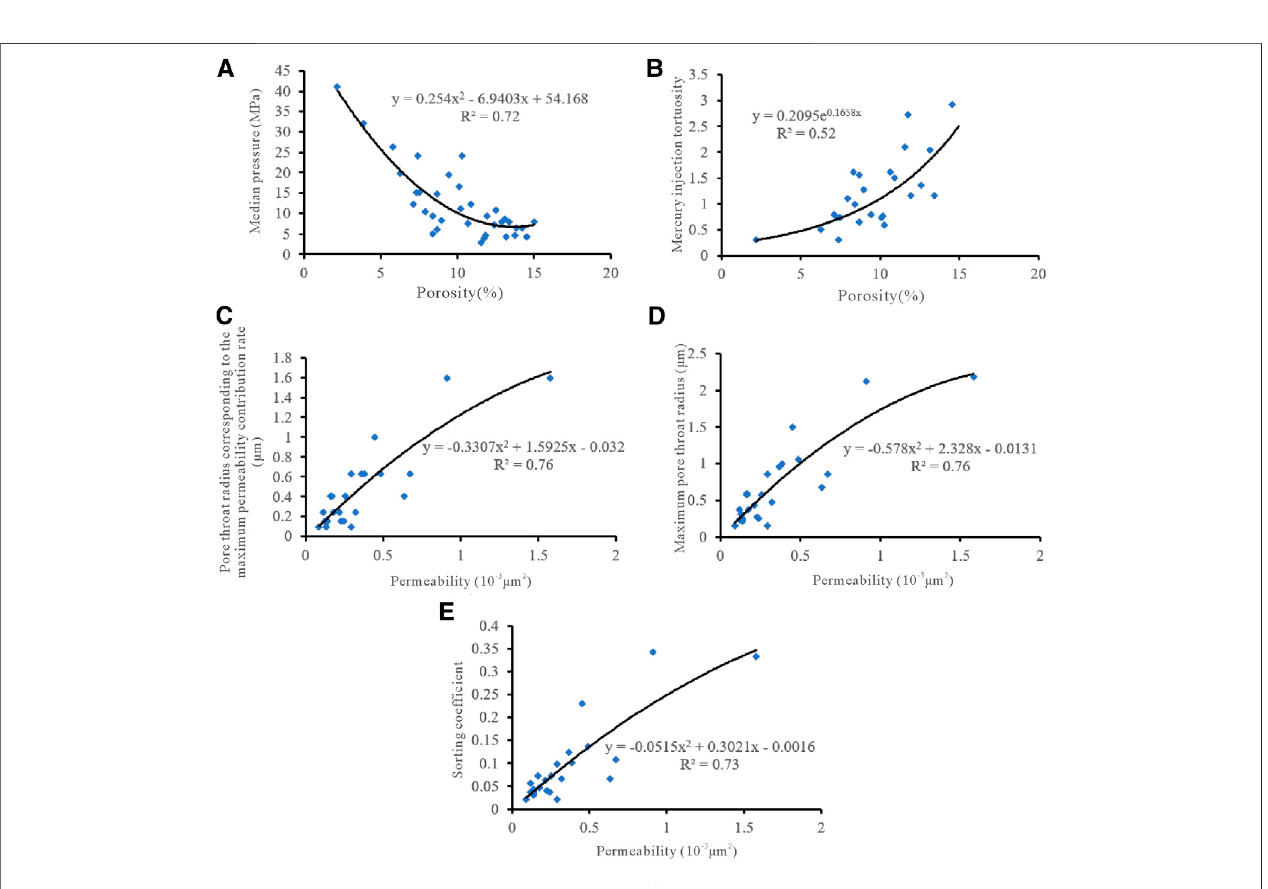
FIGURE 9 | Relationship between petrophysical properties and characteristic parameters of the pore structure of tight sandstone reservoirs in the Chang 3 Member.